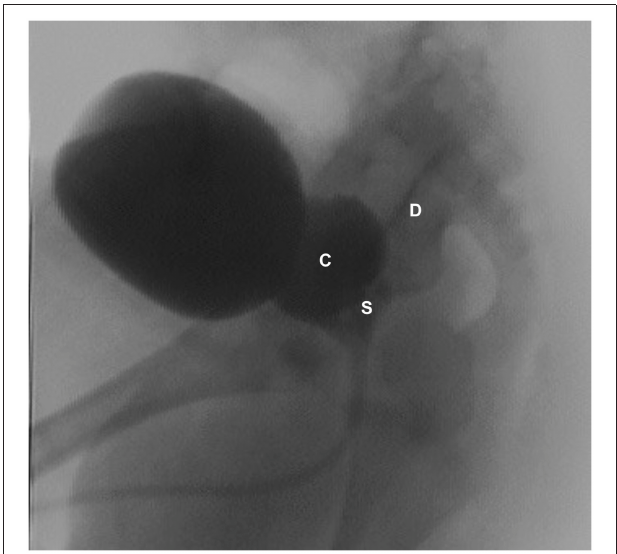
FIGURE 4 | Vesiculography (lateral view) showing bladder (B), dilated left seminal vesicle (S), seminal vesicle cysts (C), refluxing vas deferens (D), and an ectopic refluxing distal left ureter opening into a cyst